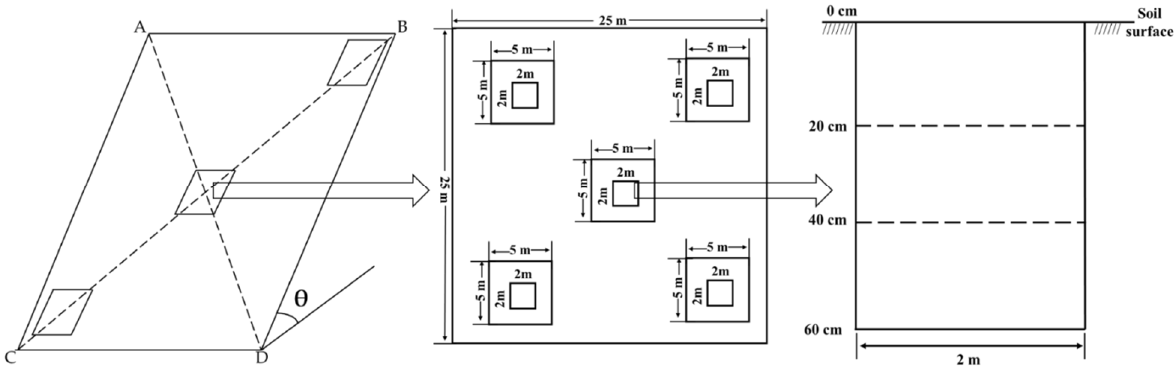
Figure 2. The diagram for the positions to collect soil samples in each